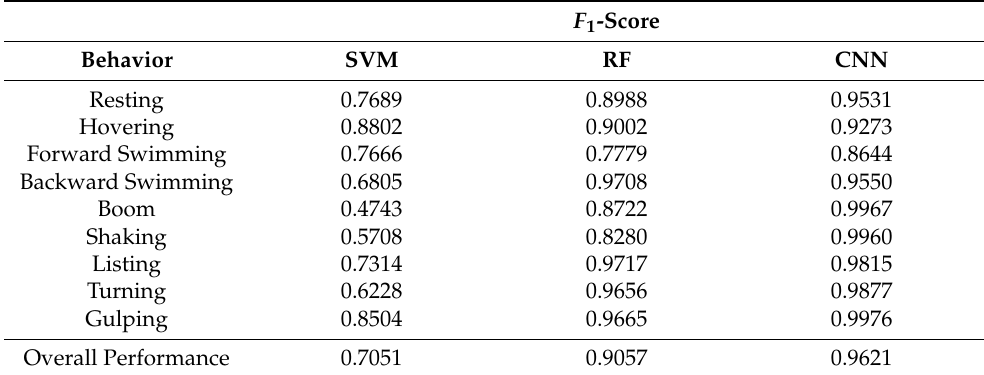
Table 7. F 1 -score results for the conventional machine learning approaches: support vector machine (SVM) and random forest (RF), and the deep learning approach: convolutional neural network (CNN).